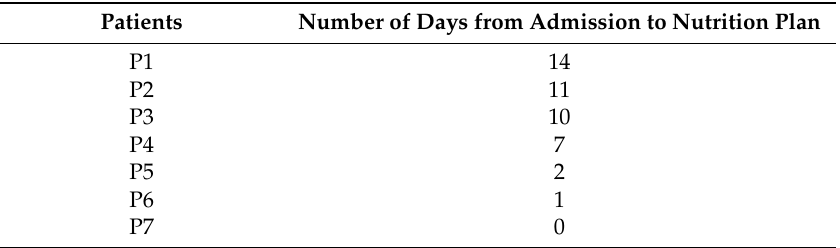
Table 1. Nutrition Planning Times.